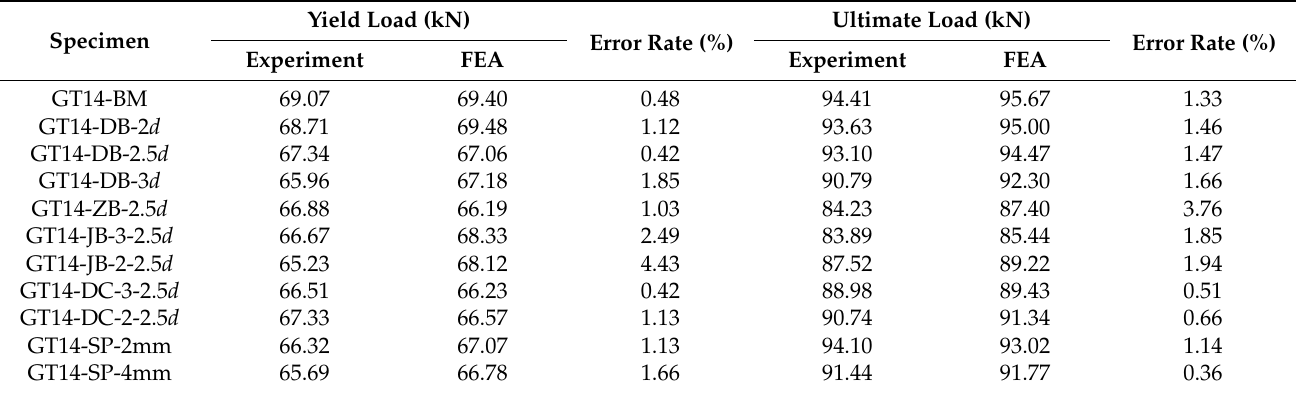
Table 11. Comparison between experimental and simulated